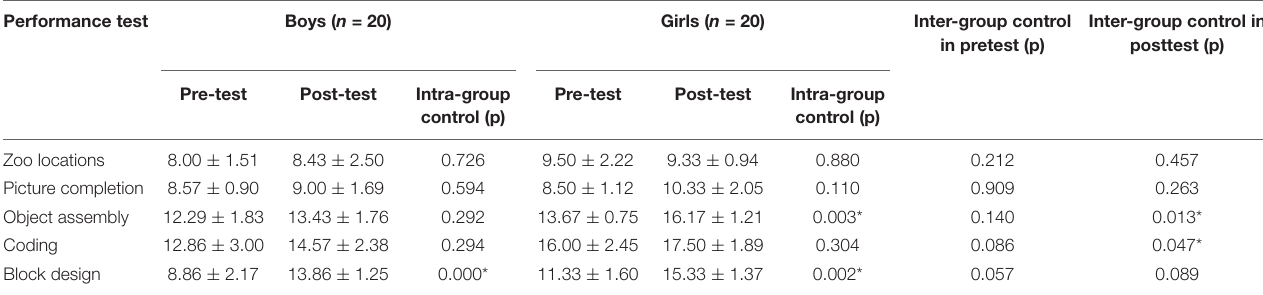
TABLE 5 | Scores of performance test items of Wechsler Intelligence Scale in experimental class according to sex before and after the experiment. Performance test Boys ( n = 20) Girls ( n =